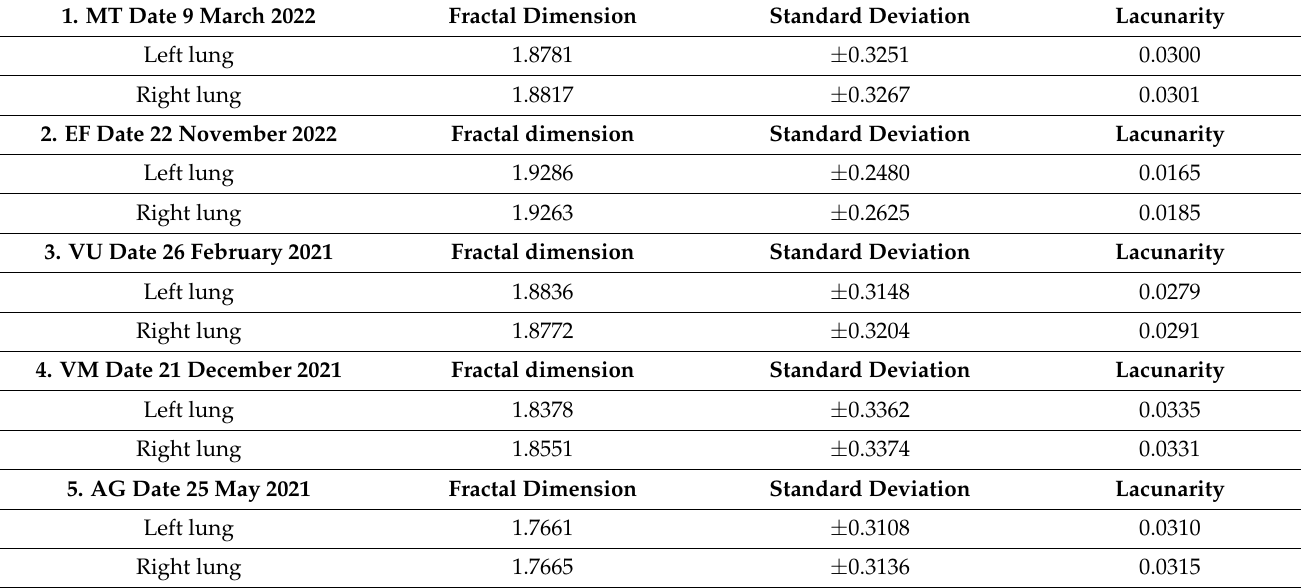
Table 6. Fractal indicators of all five investigated